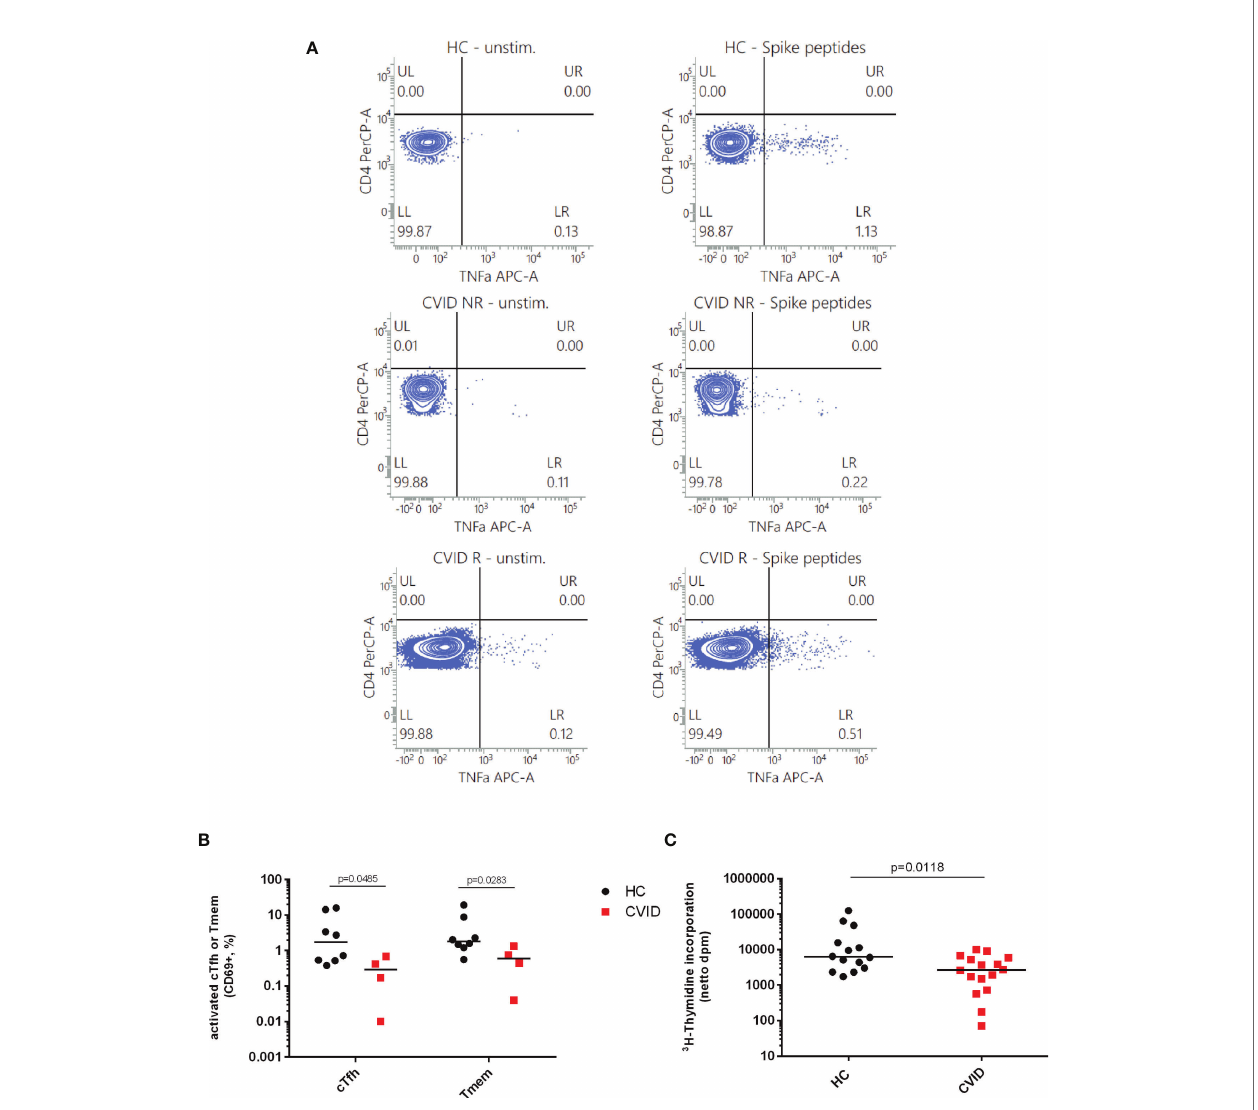
FIGURE 4 | Induction of early activation events such as CD69 expression and TNF-alpha production as well as cell proliferation as a late activation event is reduced in CD4-positive T cells from CVID patients stimulated with SARS-CoV2 spike peptides. TNF-alpha induction was measured as an early activation marker by fl ow cytometry in CD3 + CD4 + CD45RA − cells from CVID patients responding with IgG antibody production following BNT162b2 mRNA COVID-19 vaccination (CVID R), CVID nonresponders (CVID NR) and healthy controls (HC). The fi gures depicted in panel (A) are representative for a total number of four CVID patients and three healthy controls investigated. Unstimulated cells incubated in medium alone were examined in parallel. In panel (B) CD69 expression was examined by fl ow cytometry on cTfh and Tmem of CVID and healthy controls stimulated with SARS-CoV-2 spike peptides; median CD69 expression in unstimulated cells incubated in medium alone was 1.25% cTfh and 0.41% Tmem in healthy controls, and 0.66% cTfh and 0.28% Tmem in CVID patients. In panel (C) , PBMCs from healthy controls (HC) and CVID patients were stimulated for seven days using SARS-CoV2 Spike peptides before cell proliferation was examined by measuring 3 H-thymidine incorporation. Results are expressed as netto dpm of 3 H-thymindine incorporation, calculated by subtracting dpm of unstimulated cells from dpm of stimulated cells. In unstimulated PBMCs, 3 H-thymidine incorporation [dpm, median (IQR)] was 932.85 (1,838.28) in healthy controls (n = 14) and 185.15 (463.85) in CVID (n = 16). Statistical differences between two groups were determined with a non-parametric two-tailed Mann – Whitney U-test, the median is represented by a horizontal